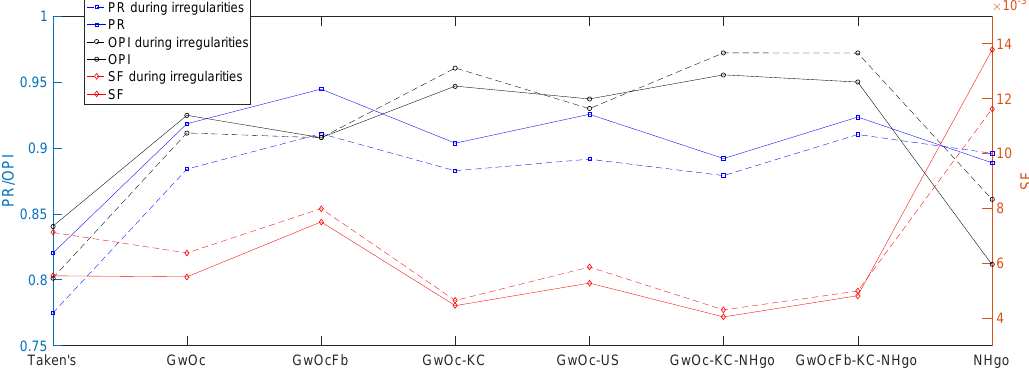
Figure 17. Performance of different methods during irregularities (left hip data).